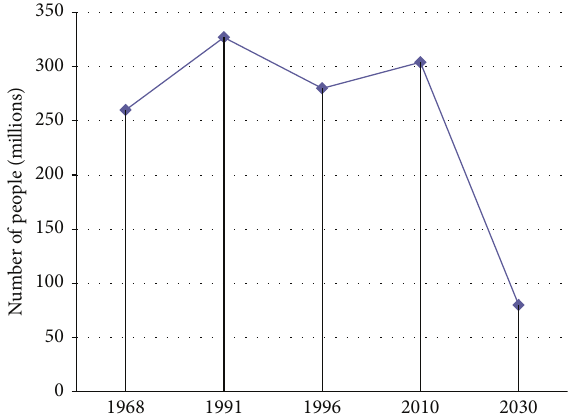
Figure 5: Percentage of population living under 1.25 $/day in South Asia. Source: world hunger and poverty facts and statistics,